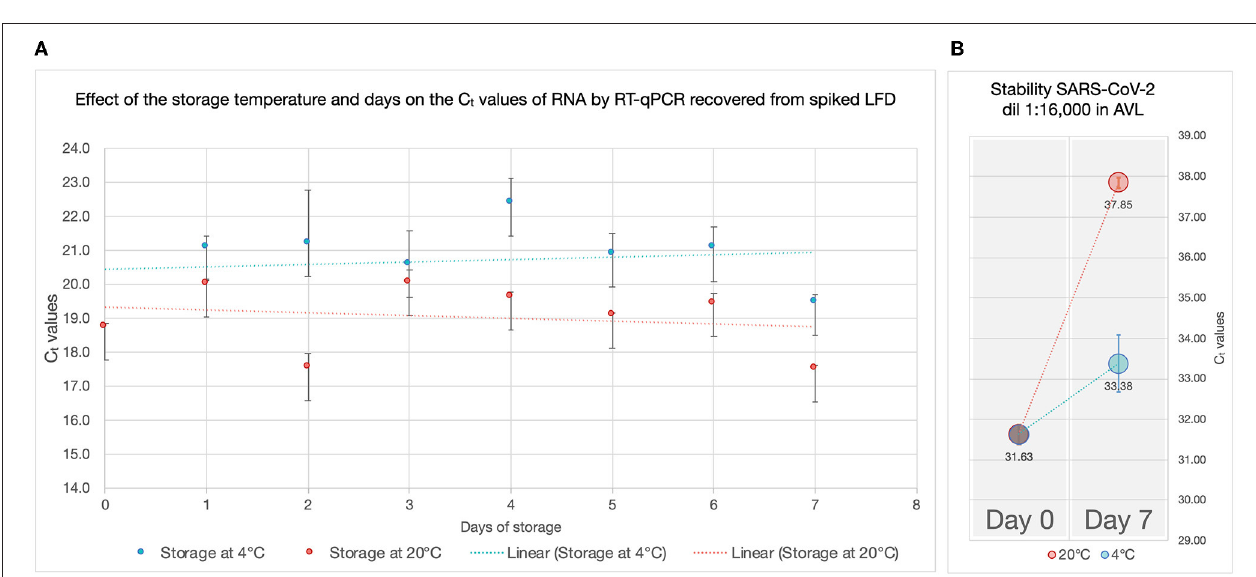
FIGURE 3 | Effect of the storage temperature and time on the C t values of RNA by RT-qPCR recovered from spiked LFD. (A) C t values (y-axes) of the RNA recovered from RADTs spiked with a high titer of SARS-CoV-2 (1 × 10 3 PFU/mL) following storage of RADTs at 4 ◦ C (blue) or 20 ◦ C (red) for 7 days. The vertical bars on the points represent the standard deviation considering the average of the two C t values recorded for each sample and the trendlines (dotted lines) are shown. (B) Stability test. A diluted concentration (1:16,000) of the virus was used for spiking RADTs and stored at 4 and 20 ◦ C. The C t values (y-axes) obtained on day 0 and 7 are shown in the plot along with the vertical bars on the points representing the standard deviation considering the average of the two C t values recorded for the measurements.